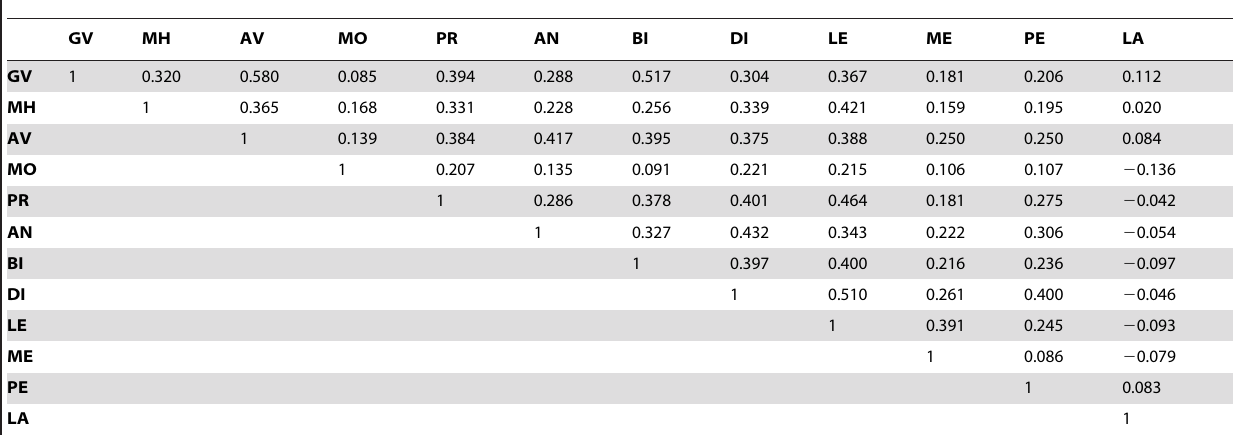
1 Correlation coefficients ( phi ) were used to measure associations between dichotomic variables and are displayed in the table. All correlations had p-values , 0.001, excepted LA-ME (0.002), LA-AN (0.03), LA-DI (0.07), LA-PR (0.10), and LA-MH